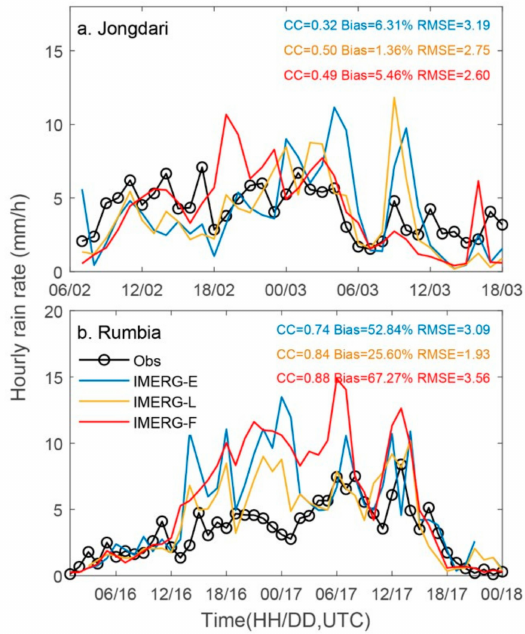
Figure 3. Temporal distribution of hourly rain rate over Yangtze River Delta